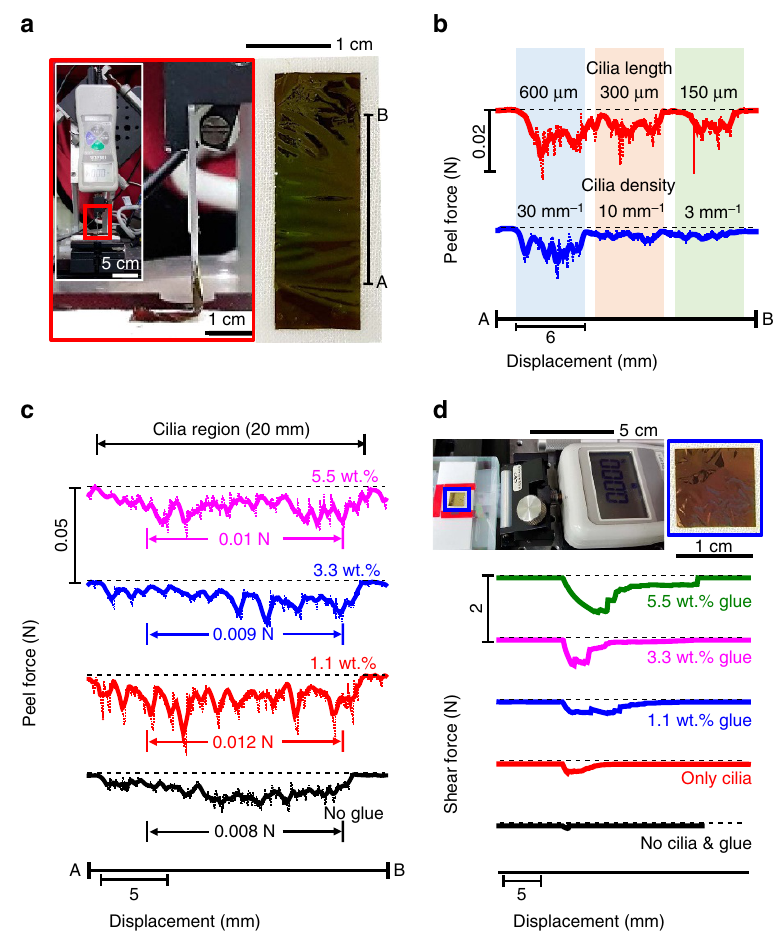
Figure 3 | Mechanical analyses of the enhanced adhesion by cilia and glue. ( a ) Photographs of the measurement set-up ( a -left) and a substrate ( a -right) used in the peel test. ( b , c ) Peel force profiles of the substrates with various cilia length scales ( b -top), densities ( b -bottom) and concentrations of the PDMS glue solution in toluene ( c ). ( d ) Photographs of the measurement set-up and a substrate used in the shear test ( d -top) and the shear force profiles of the substrates with or without cilia (thickness ¼ 1.4 m m, width ¼ 10 m m, length ¼ 600 m m, density ¼ 30mm (cid:3) 1 ) and various concentrations of PDMS glue solution in toluene ( d -bottom). Shear rate is set to be 0.3mms (cid:3) 1 . The textile used in these mechanical tests is the same as that used in Fig.